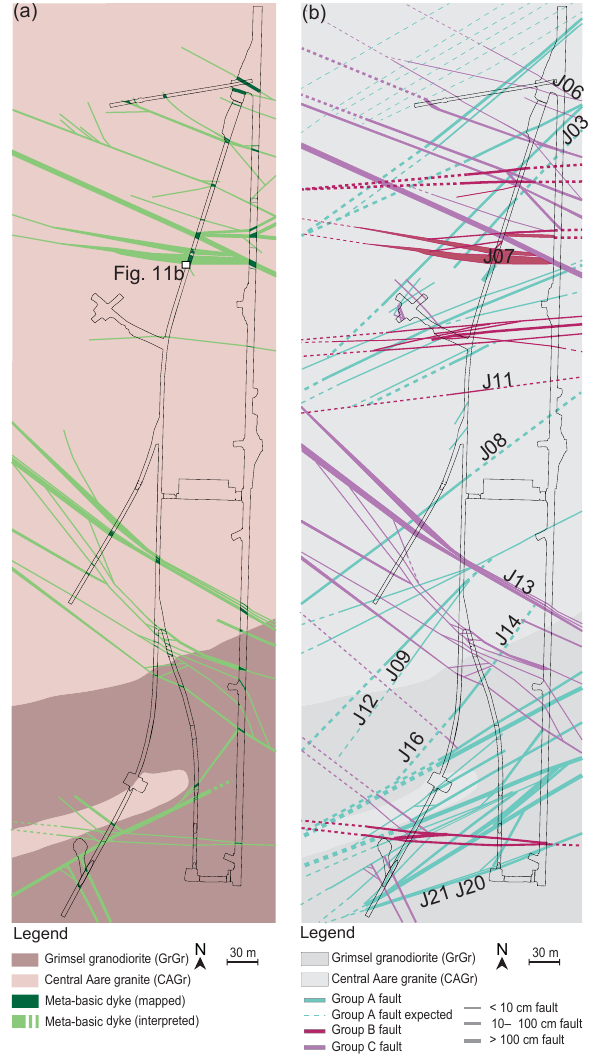
Figure 8. (a) Petrographic underground map. (b) Structural map- ping (1:1000) of the underground rock laboratory (GTS) with faults grouped according to their strike. Indicated labels correspond to sur- face fault labelling and represent the maximum a posteriori interpo-